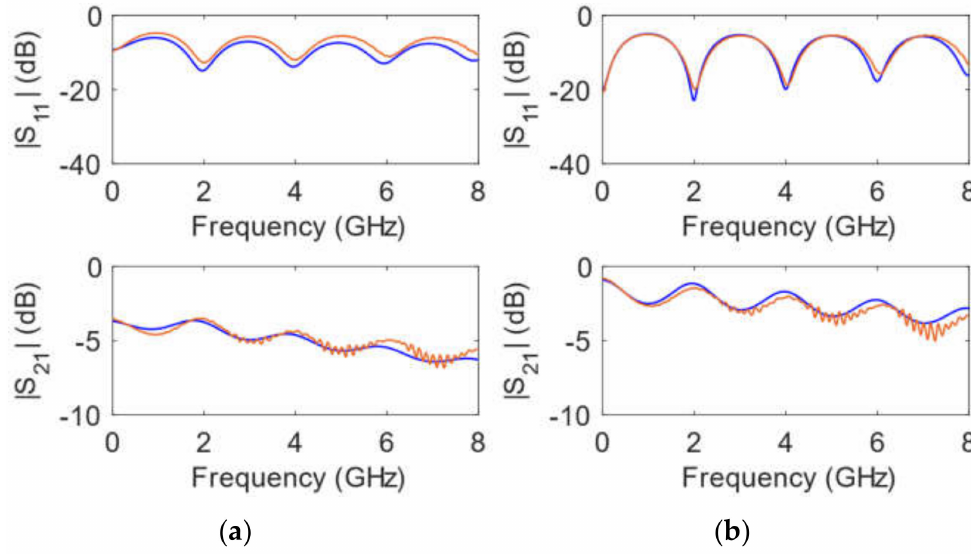
Figure 12. Simulated ( blue ) and measured ( orange ) magnitude of the scattering parameters for a 50 mm long transmission line ( w = 0.85 mm) for the h = 1.6 mm substrate height: ( a ) just metallic paint is applied; ( b ) after electroplating is also carried